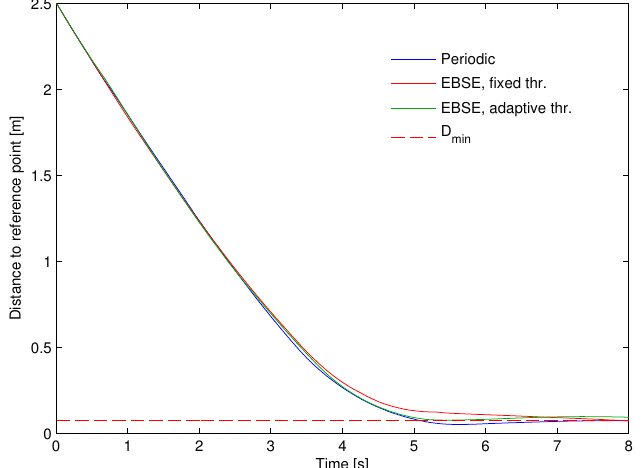
Figure 8. Distance to the point of the corresponding reference trajectory over time for the first eight seconds of the simulation (approaching